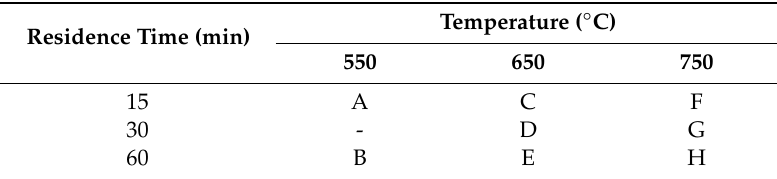
Table 3. Treatment